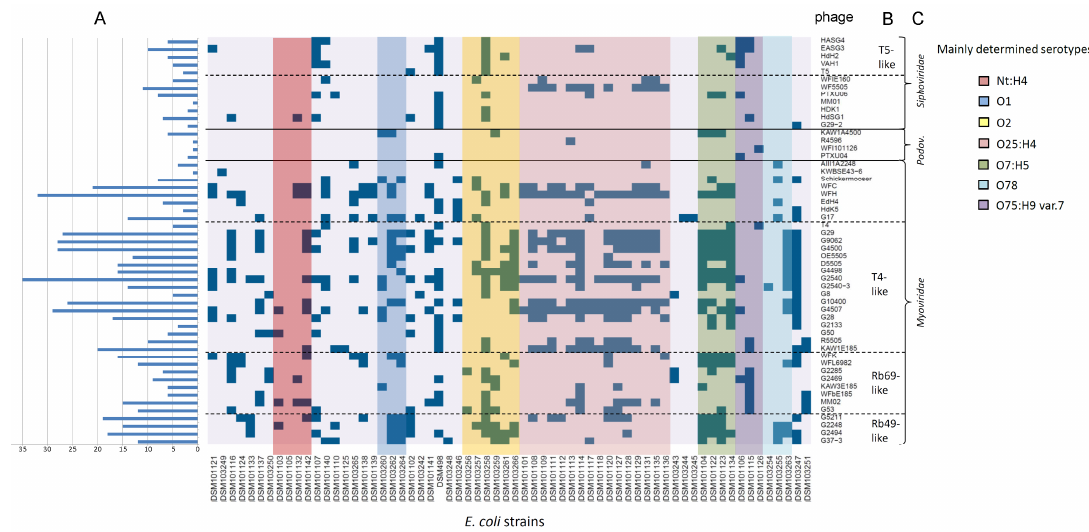
Figure 4. Analysis of the lytic behavior of isolated phages on a set of 64 Escherichia coli strains from various serotypes. Blue squares indicate plaque formation of a given phage. The number of strains that were successfully lysed by a given phage are shown in ( A ). Order of the phages ( y -axis) is based on morphology ( C ) and taxonomic classification ( B ), respectively. The order of E. coli strains is based on determined serotypes. As there are many T4-like and T5-like phages in our study, phages T4 and T5 were also included in this